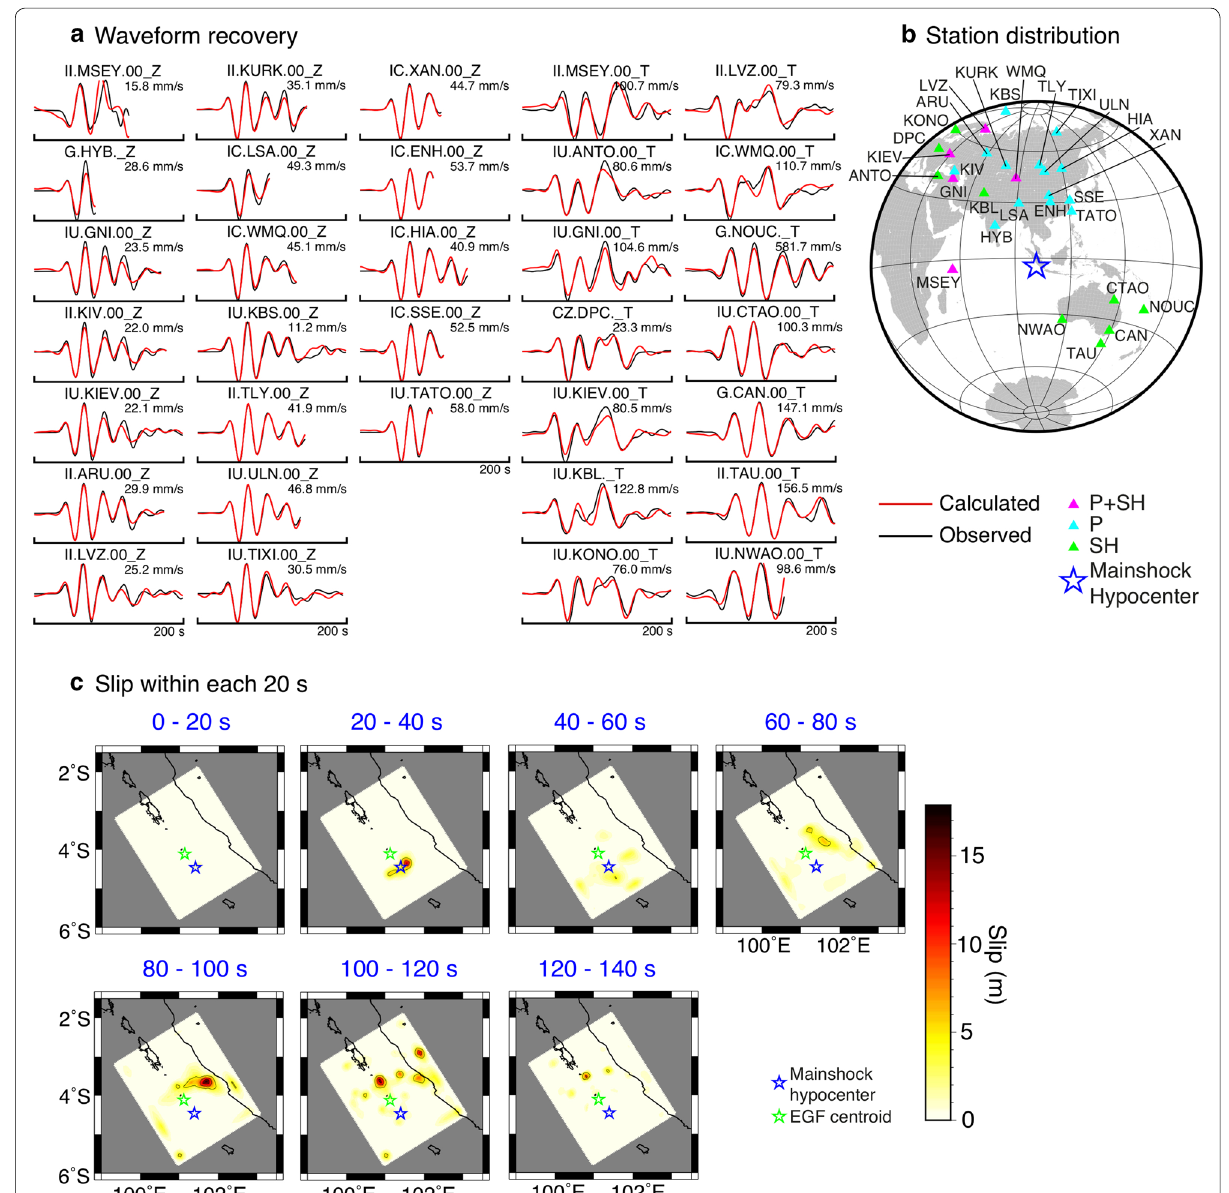
Fig. 2 Slip inversion for the Bengkulu Earthquake using EGF4. a Observed (black) and calculated (red) velocity waveforms via slip inversion of the Bengkulu Earthquake using EGF4 (14 Sep 2007, M W 6.4 ), b station distribution for the data used in the slip inversion, and c spatiotemporal slip distribution for each 20‑s interval. Blue, green, and pink triangles in b represent the stations where the P, SH, or both P and SH phases were used in the inversion, respectively. Blue stars in b and c mark the hypocenter of the Bengkulu Earthquake in the ISC catalog (International Seismological Centre 2019), and green stars in c represent the relocated centroids of the EGF